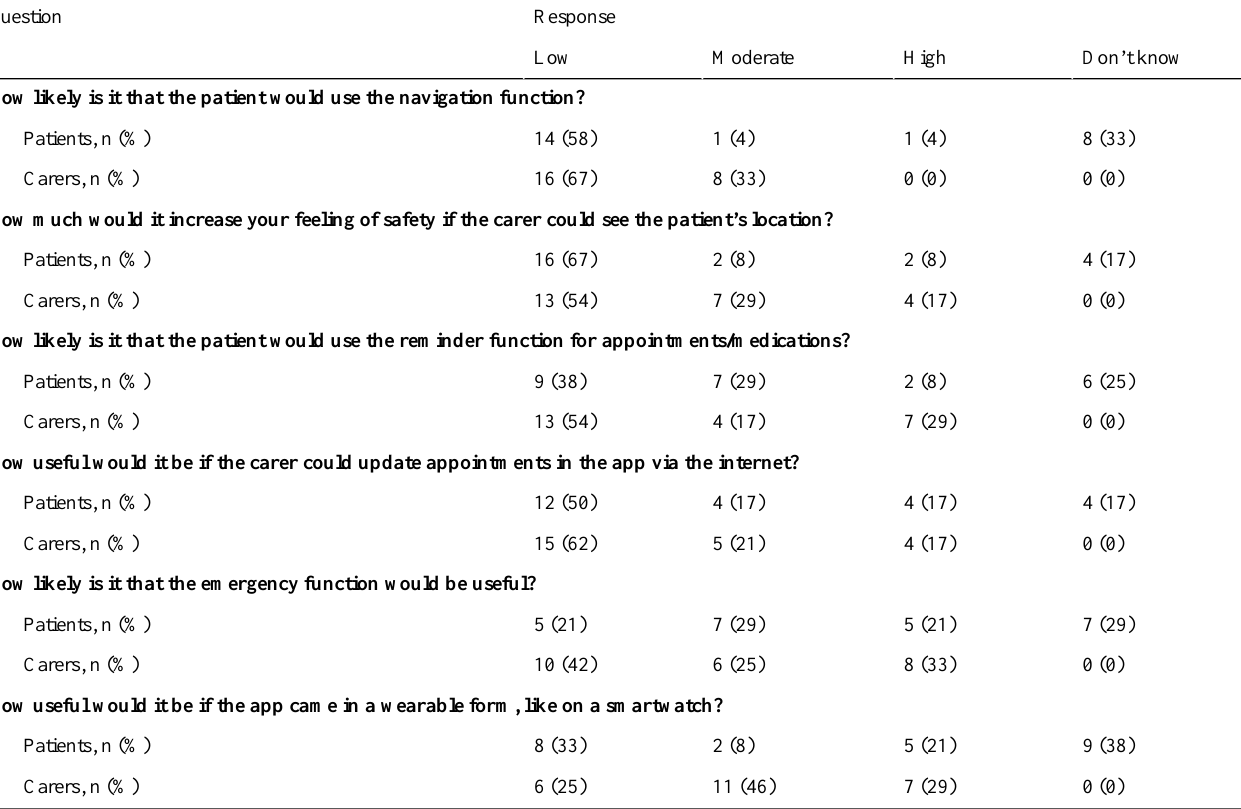
Table 3. Patients’(N=24) and carers’(N=24) ratings of the usefulness of the app’s functions.